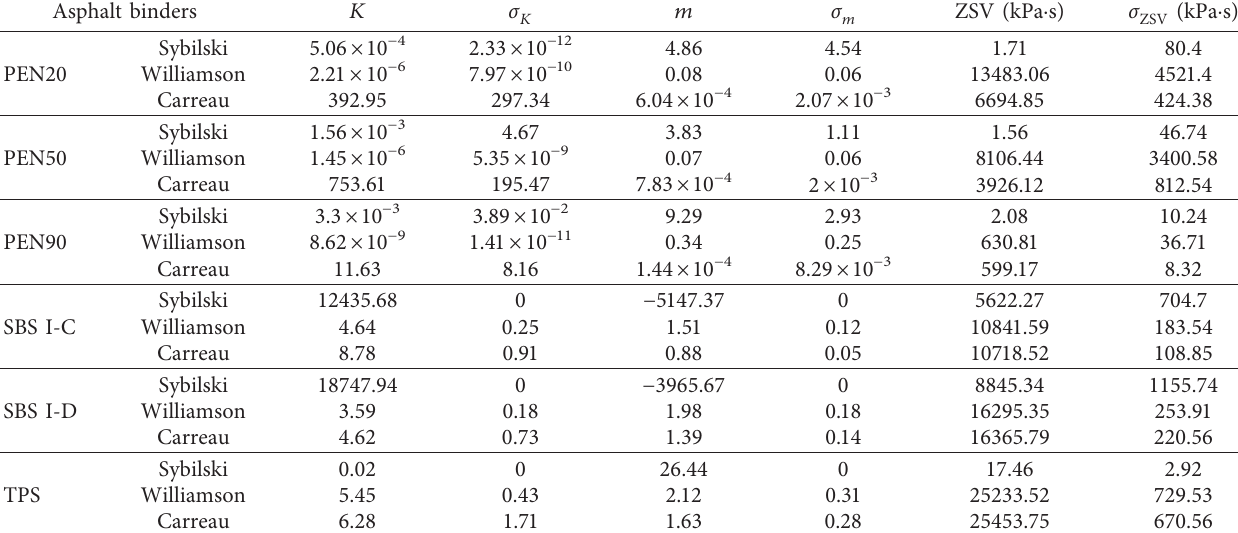
Table 4: Fitting K,m , and ZSV values in three ZSV